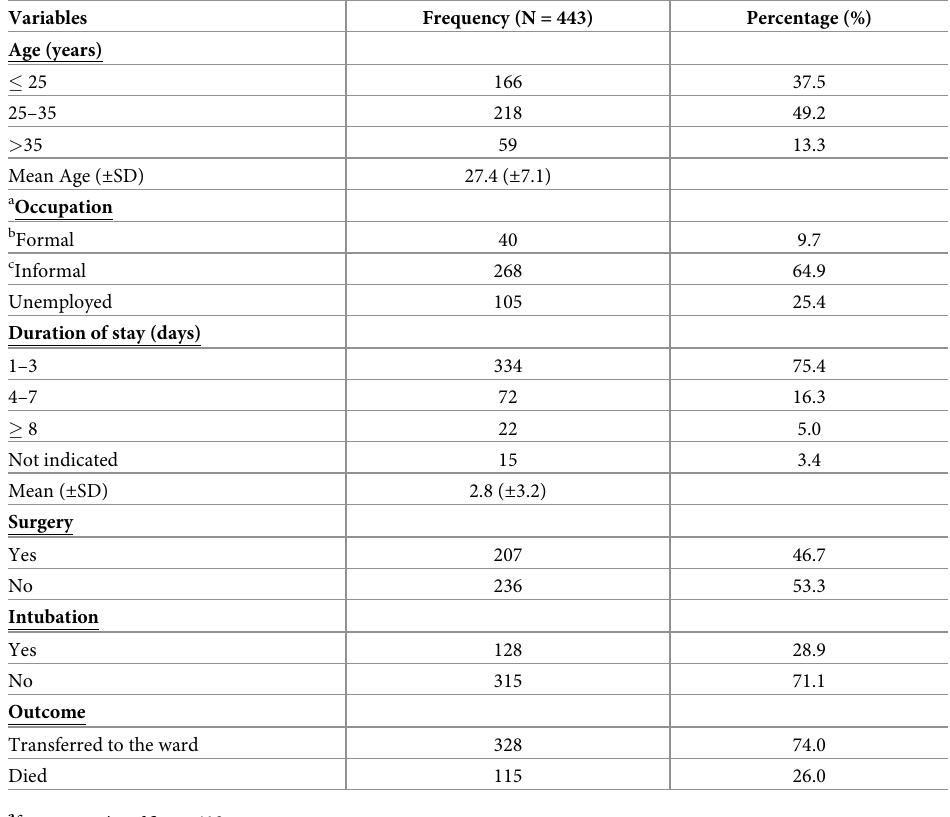
Table 1. Background and clinical characteristics of study